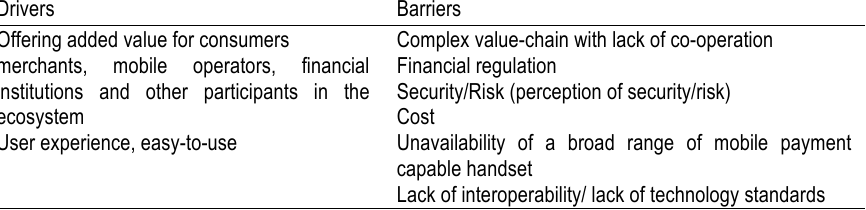
Table 1. Adoption of m-payments: drivers and barriers Drivers